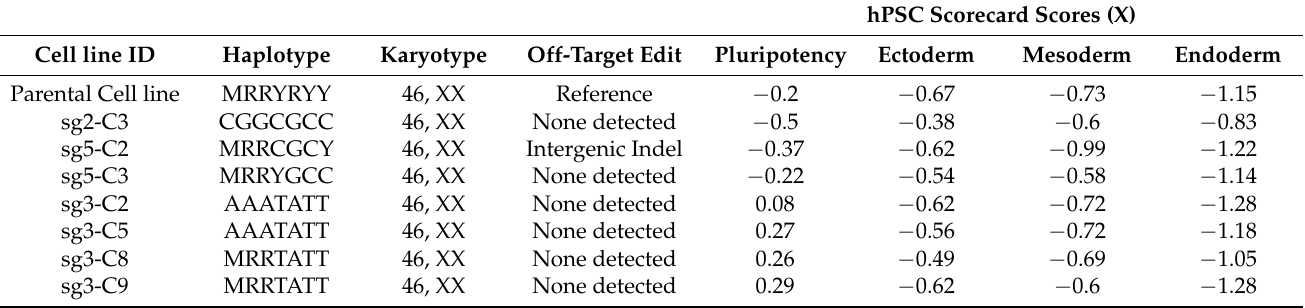
Table 1. Genomic Stability, CRISPR-cas9 off-target effects, and pluripotency in the established isogenic cell